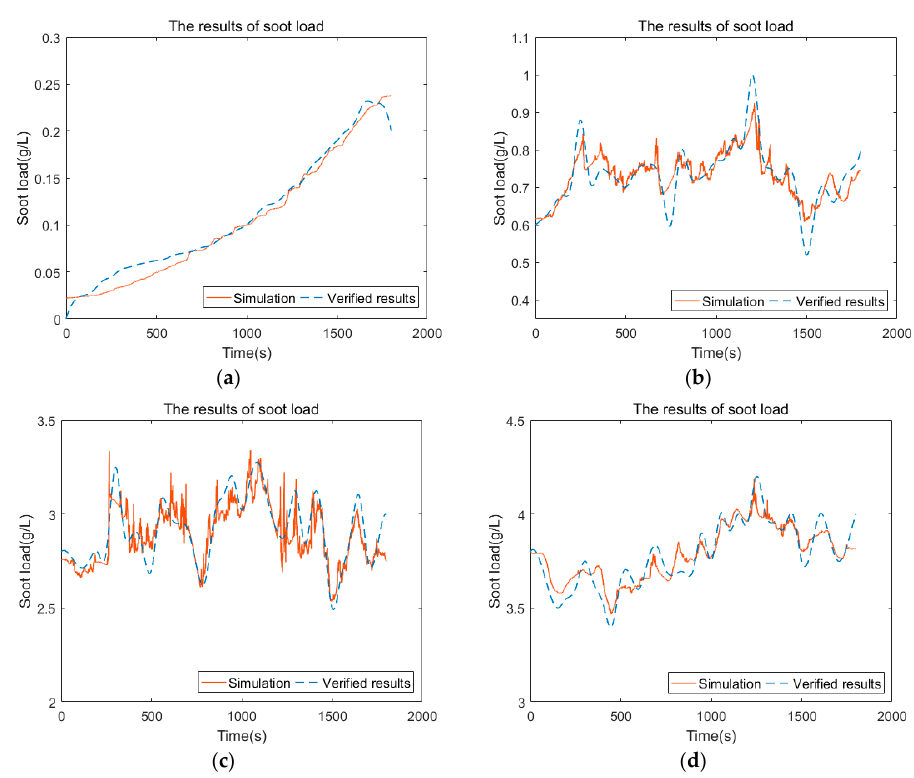
Figure 5. The results of the soot load: ( a ) Soot load of the 1st cycle; ( b ) Soot load of the 4th cycle; ( c ) Soot load of the 15th cycle; ( d ) Soot load of the 20th cycle. Table 5. Error of the results.